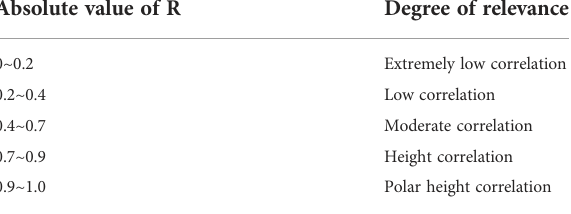
TABLE 1 Classi fi cation standard of correlation degree (Barnes, 2007). Absolute value of